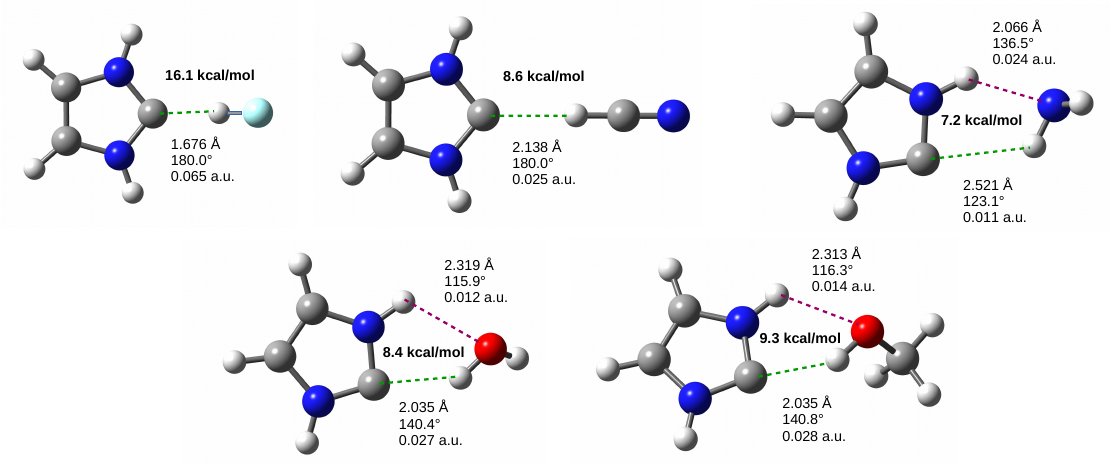
Figure 4. Imidazol-2-ylidene dimers with HF, HCN, NH 3 , H 2 O and MeOH. The values of the dissociation energy are given in bold, while the three values next to the interaction shown refer to the length of the hydrogen bond, its angle and the value of the electron density at the bond critical